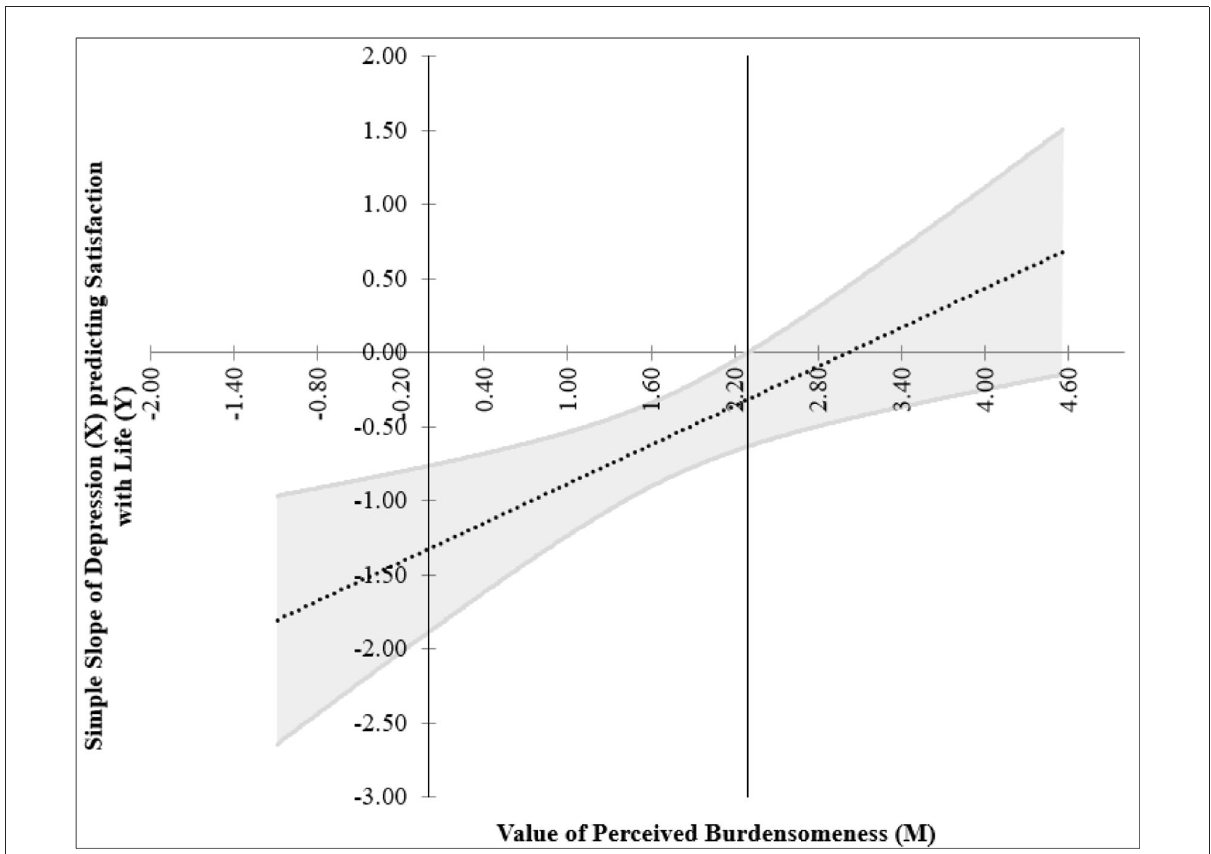
FIGURE2 Johnson–Neyman regions representing the threshold for significant of the effects of focal predictor (depression) on the outcome variable (satisfaction with life) for different levels of moderator (perceived burdensomeness).